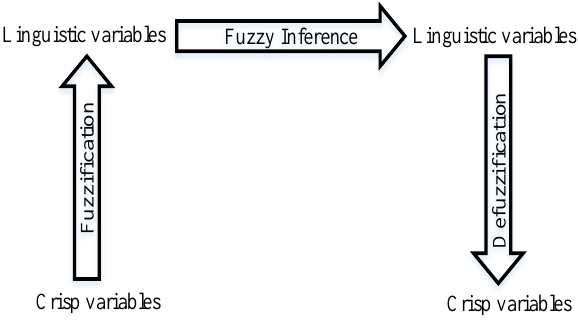
Figure 9. Fuzzification and defuzzification